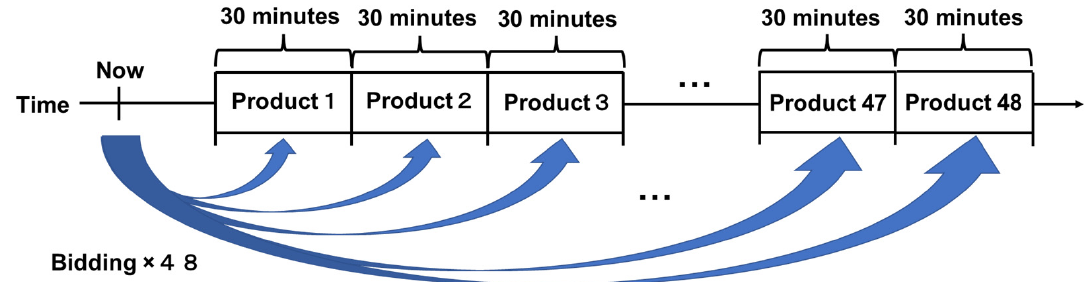
Figure 5. Simultaneous bidding on multiple markets.